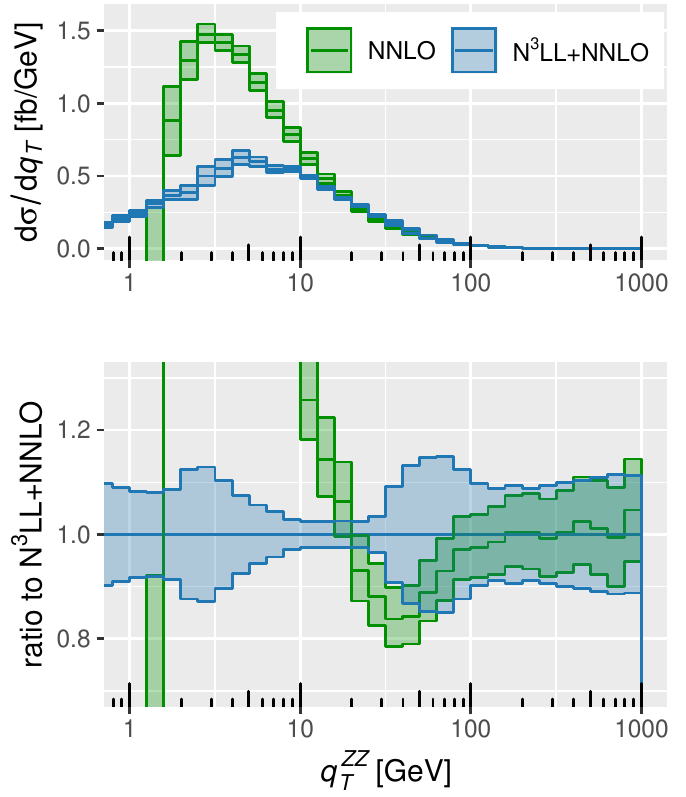
Figure 1 . Transverse momentum distribution of the ZZ pair at NNLO and N 3 LL+NNLO using the CMS cuts in table 2 [25], but at 13 . 6 TeV